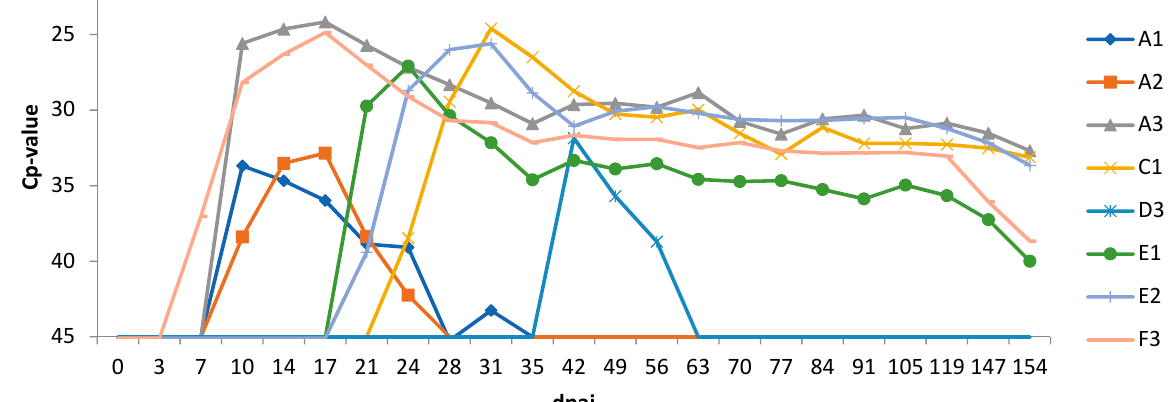
Figure 1. RNAemia as determined by real-time RT-PCR detection of BTV genome in blood of heifers infected with BTV-8 contaminated semen from natural-infected bulls. dpai: days post artificial insemination.